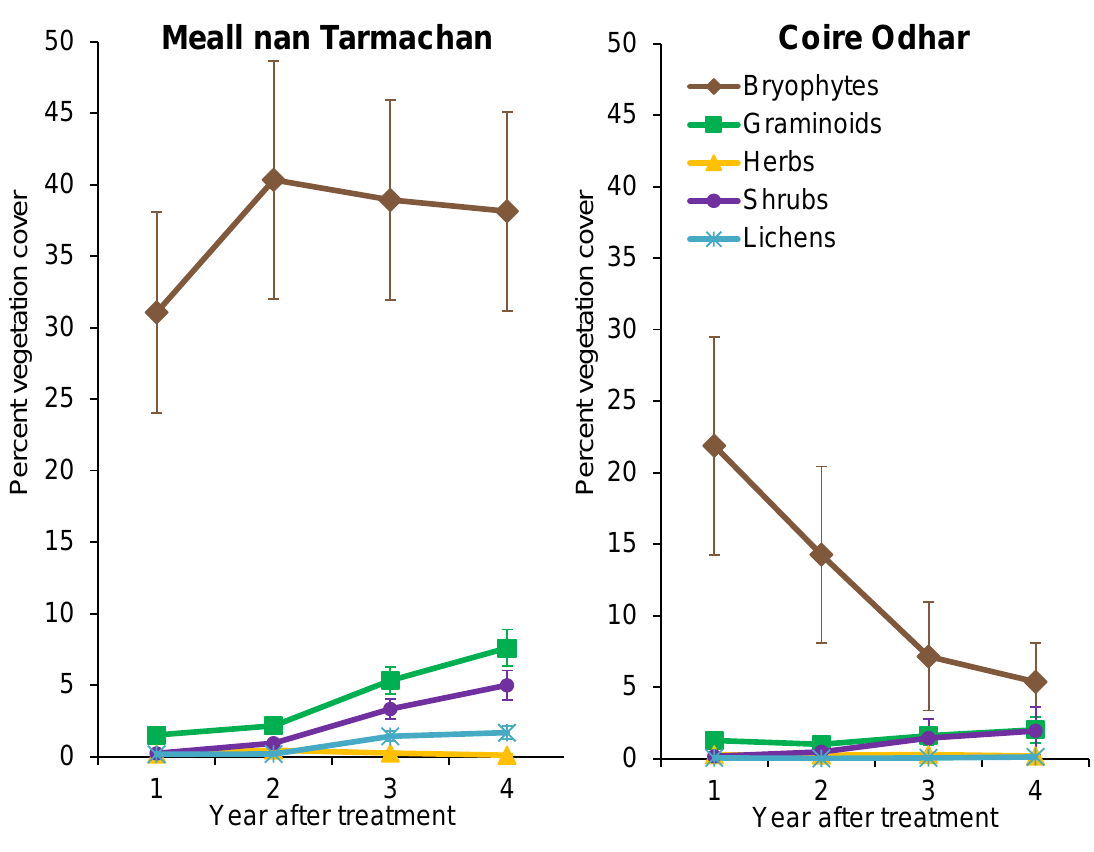
Figure 4. The mean percent cover of different species groups recorded in the plots at Meall nan Tarmachan (MT) and Coire Odhar (CO) in the four years following treatment of bare peat. Error bars are ± 1